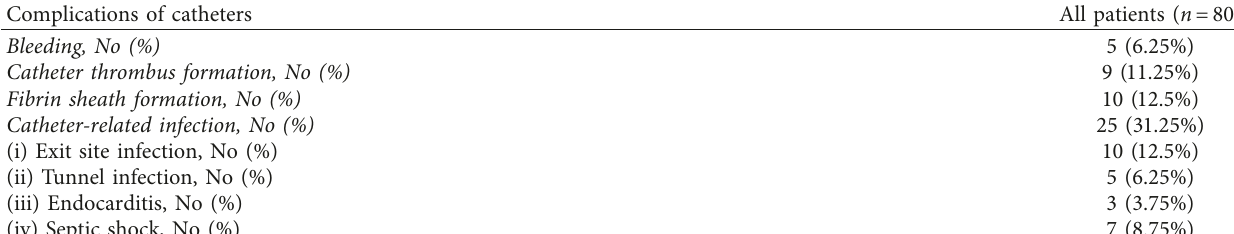
Table 3: Complications of catheters.